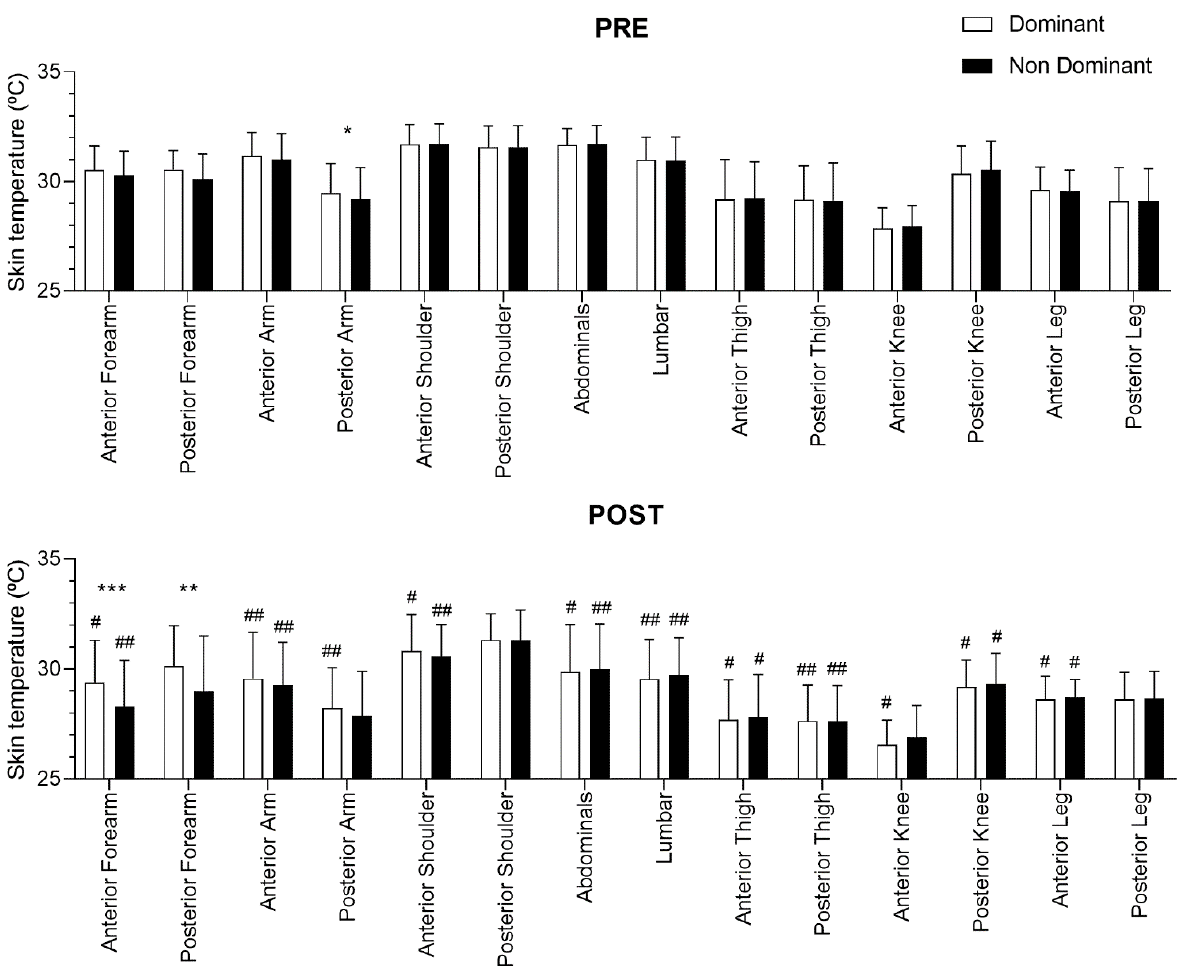
Figure 4. Results of skin temperature comparisons. Differences found between the dominant and non-dominant sides, at the same time, are shown by an asterisk (* p < 0.05; ** p < 0.01; *** p < 0.001). On the other hand, # indicates the differences found between the pre and post of each of the regions (# p < 0.05; ## p < 0.01).